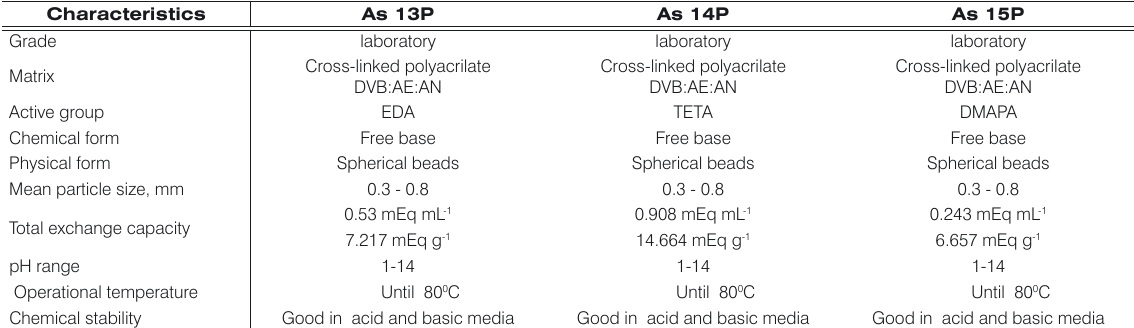
Table 1. Characteristic data of tested acrylic